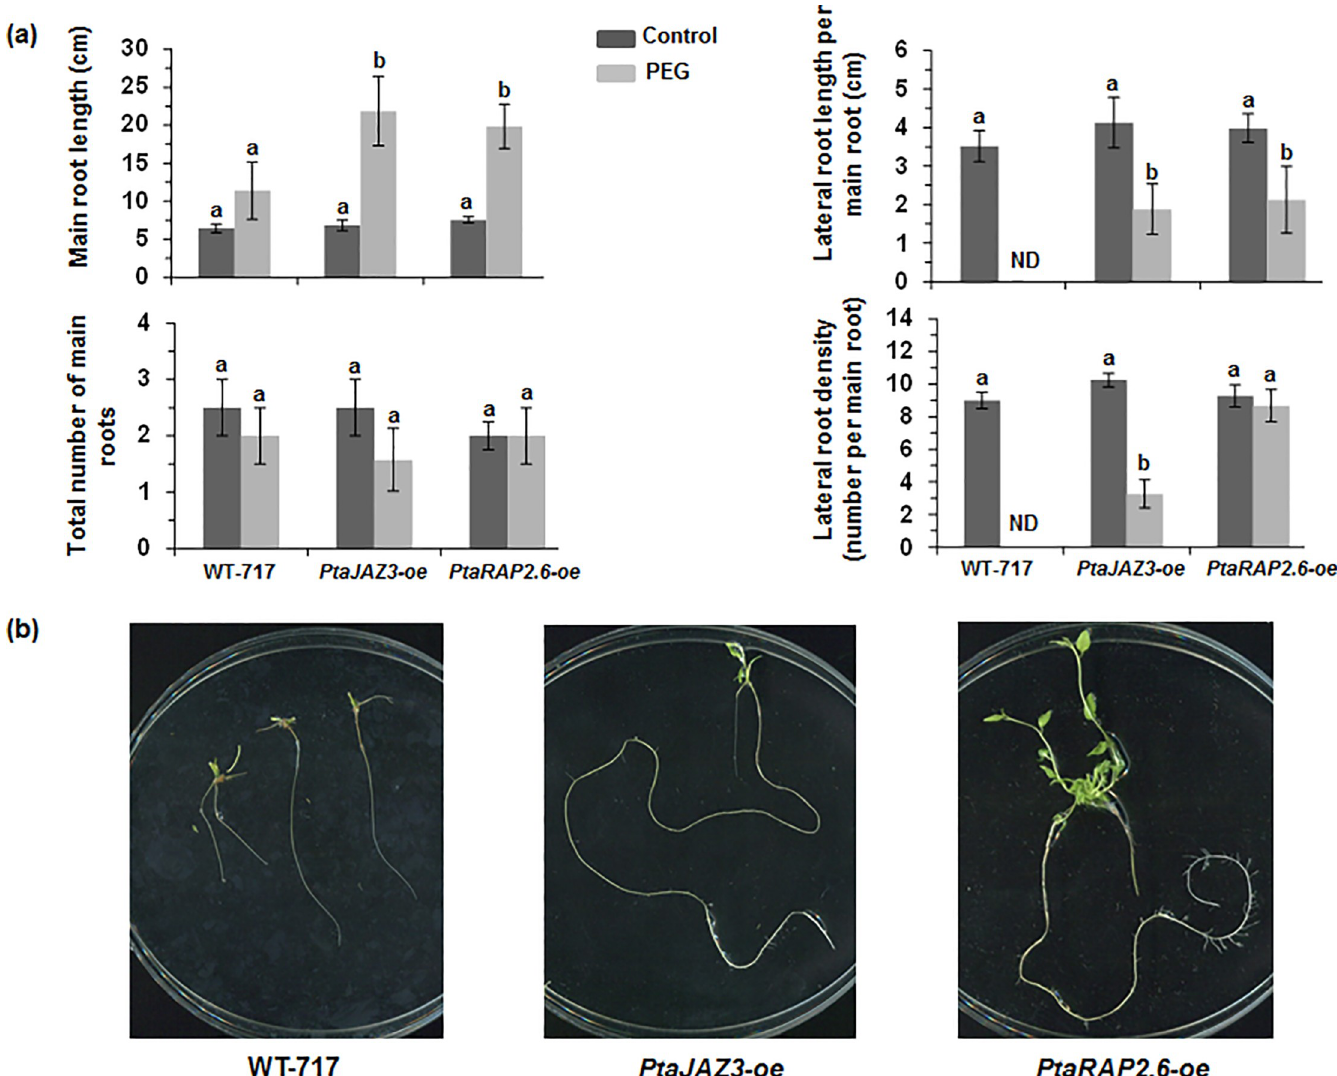
Fig 2. PtaJAZ3 and PtaRAP2 . 6 overexpression affects root growth in response to PEG-induced drought stress. (a) Root growth of PtaJAZ3 and PtaRAP2 . 6 overexpressing transgenics in comparison with those of WT-717 in both control (darker bars) and PEG (lighter bars) media. Three independent lines (four replicates per line, see S3 Fig) were measured for calculating the values of each transgenic modification that is shown as mean ± standard error of mean (SEM) ( n = 3). Different letters represent means that are statistically different ( P < 0.05) as determined by a one-way ANOVA followed by Tukey’s multiple range tests. (b) Representative photos of roots from the three genotypes grown in PEG liquid media for 40 days (see materials and